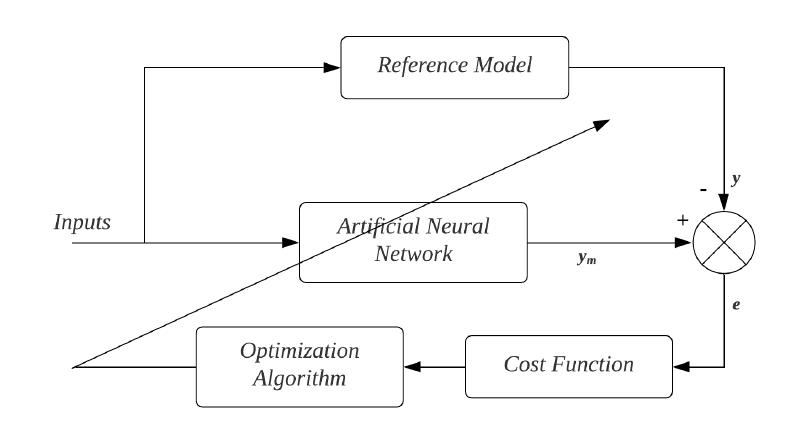
Figure 2. Estimation diagram by reference